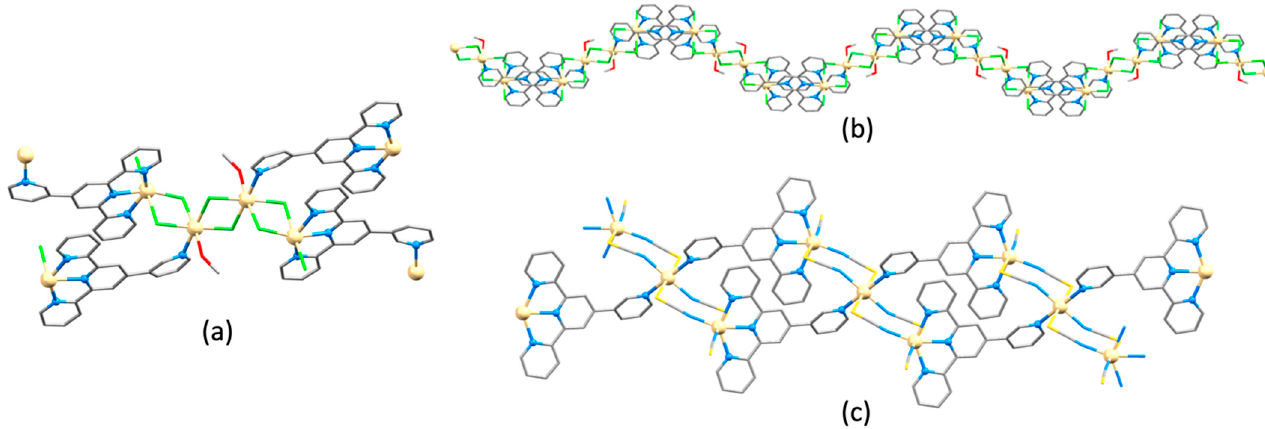
Figure 3. The structure of [Cd 2 Cl 4 (4’ ‐ (3 ‐ py)tpy)(MeOH)] n (CSD refcode RIXDOS): (a) ligands are connected by tetracad ‐ mium 4 ‐ connecting nodes, and (b) 2D ‐ sheets assemble with a wave ‐ like profile. (c) Part of the 1D ‐ chain in [Cd 3 SCN) 6 (4’ ‐ (3 ‐ py)tpy) 2 ] n . 2 n THF (refcode RIXDIM).